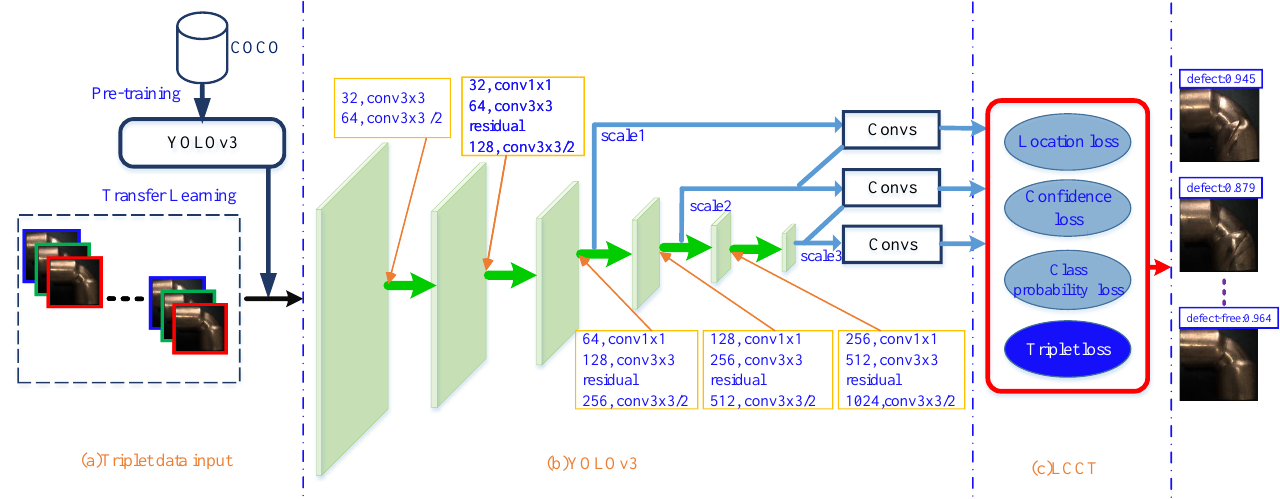
Figure 1. The architecture of YOT-Net. YDT-Net is a surface defect detection model and mainly composed of three basic components: ( a ) Triplet data input module. ( b ) YOLOv3 feature extract module. ( c ) LCCT (Location-Confidence-Class probability-Triplet) loss